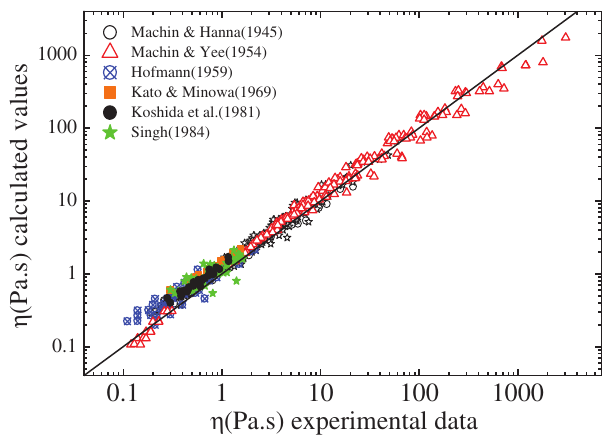
Figure 2: Comparison between the calculated and experimental